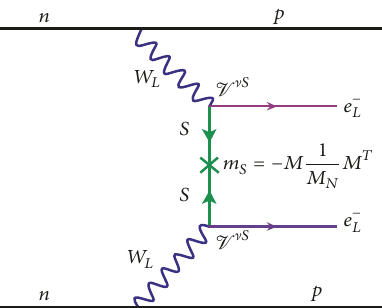
Figure 4: Feynman diagram representing neutrinoless double beta decay amplitude due to exchanges of singlet fermions 𝑆 푖 (𝑖 = 1 − 3) with explicit mass insertion 𝑚 푠 = −𝑀(1/𝑀 푁 )𝑀 푇 .